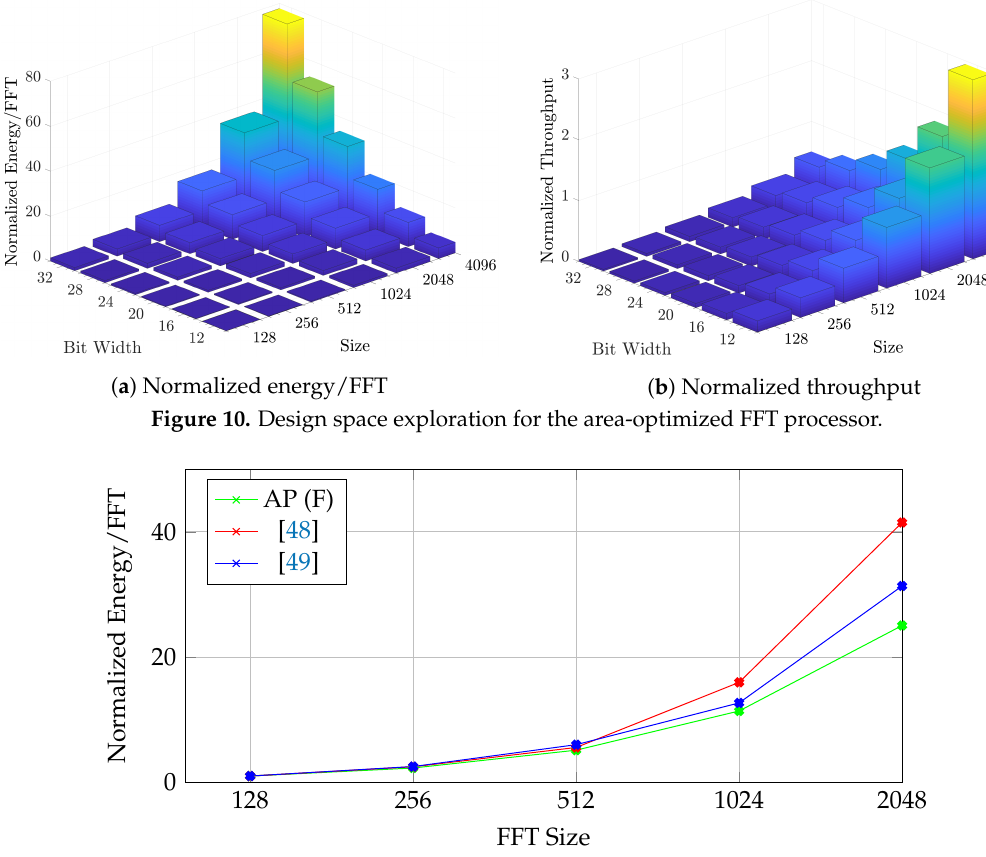
Figure 11. Comparison of normalized Energy/FFT scaling with respect to FFT